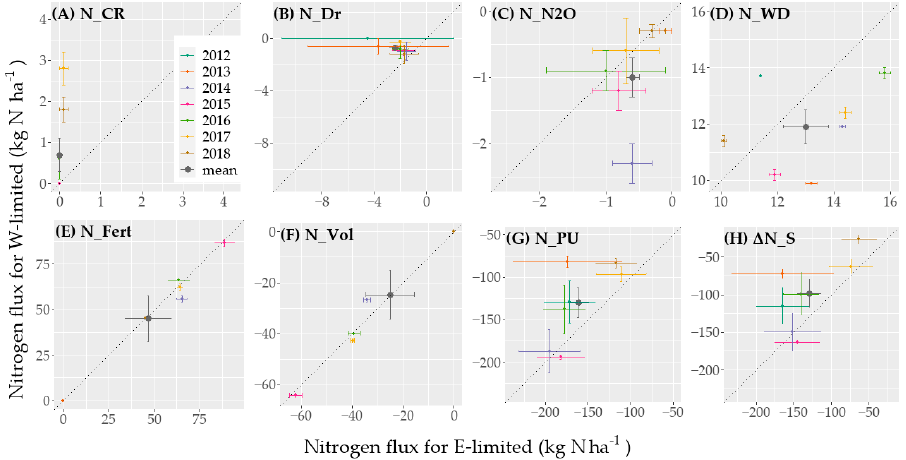
Figure 5. The different components of annual nitrogen balance for lysimeters from Rollesbroich in Rollesbroich the energy-limited site (E-limited, x-axis) and Selhausen the water-limited site (W- limited, y-axis) for ( A ) nitrogen in the upward directed water (N_CR), ( B ) nitrogen in drainage water (N_Dr), ( C ) nitrogen lost by N 2 O emissions (N_N 2 O), ( D ) nitrogen in wet deposition (N_WD), ( E ) nitrogen input by fertilizer (N_Fert), ( F ) ammonia volatilization of the fertilizer nitrogen (N_Vol), ( G ) plant nitrogen uptake (N_PU), and ( H ) the resulting soil nitrogen storage ( Δ N_S). The negative values represent a nitrogen loss for the lysimeters; “mean” in the legend indicates the mean annual values for the period 2012–2018 and the inter-annual variability is rep- resented by the standard error of annual means. There are gaps in the N 2 O emission data for the years 2013 and 2018 resulting in lower yearly emissions.